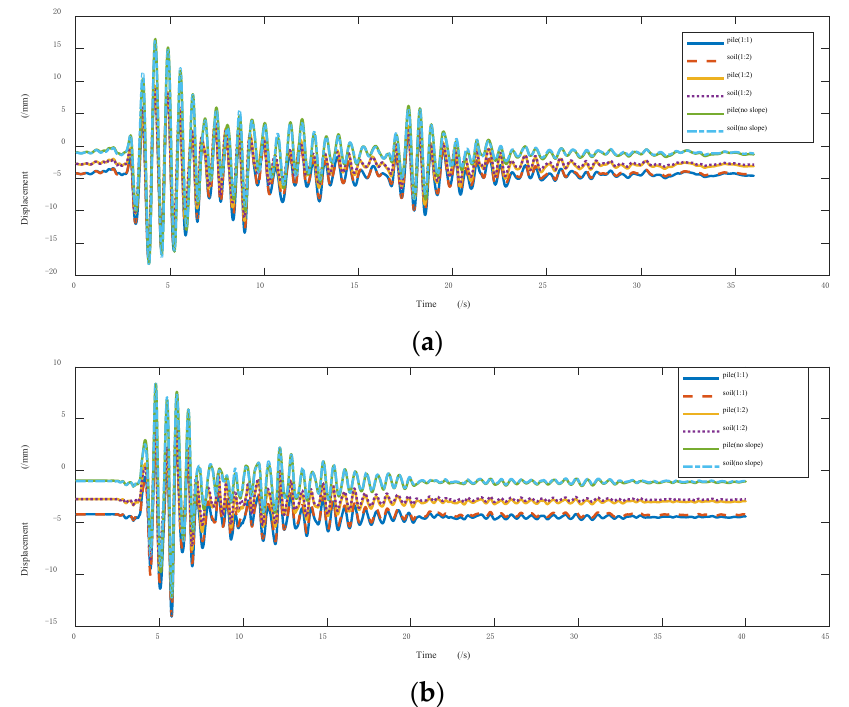
Figure 10. Displacement time history curve of pile and soil (at 3 m buried depth): ( a ) working condition 6; ( b ) working condition 18.